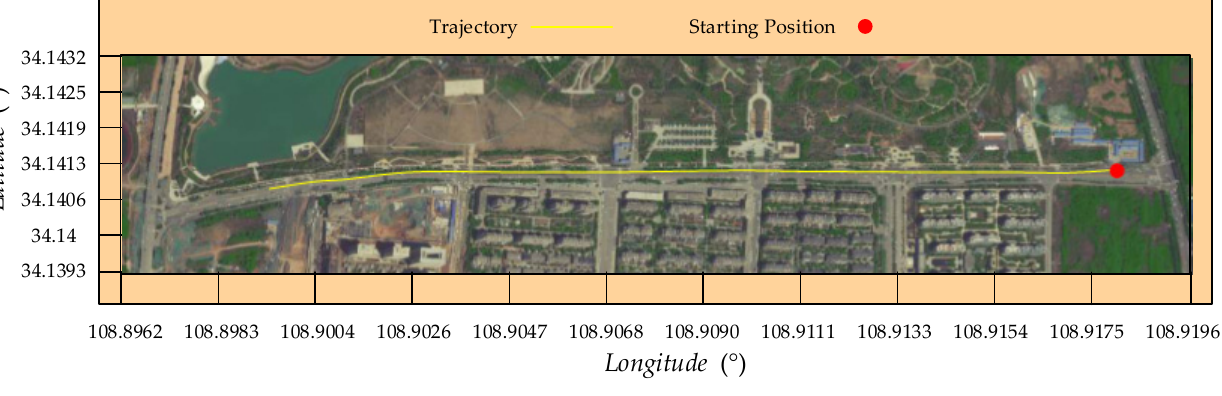
Figure 6. The trajectory of the urban road test.